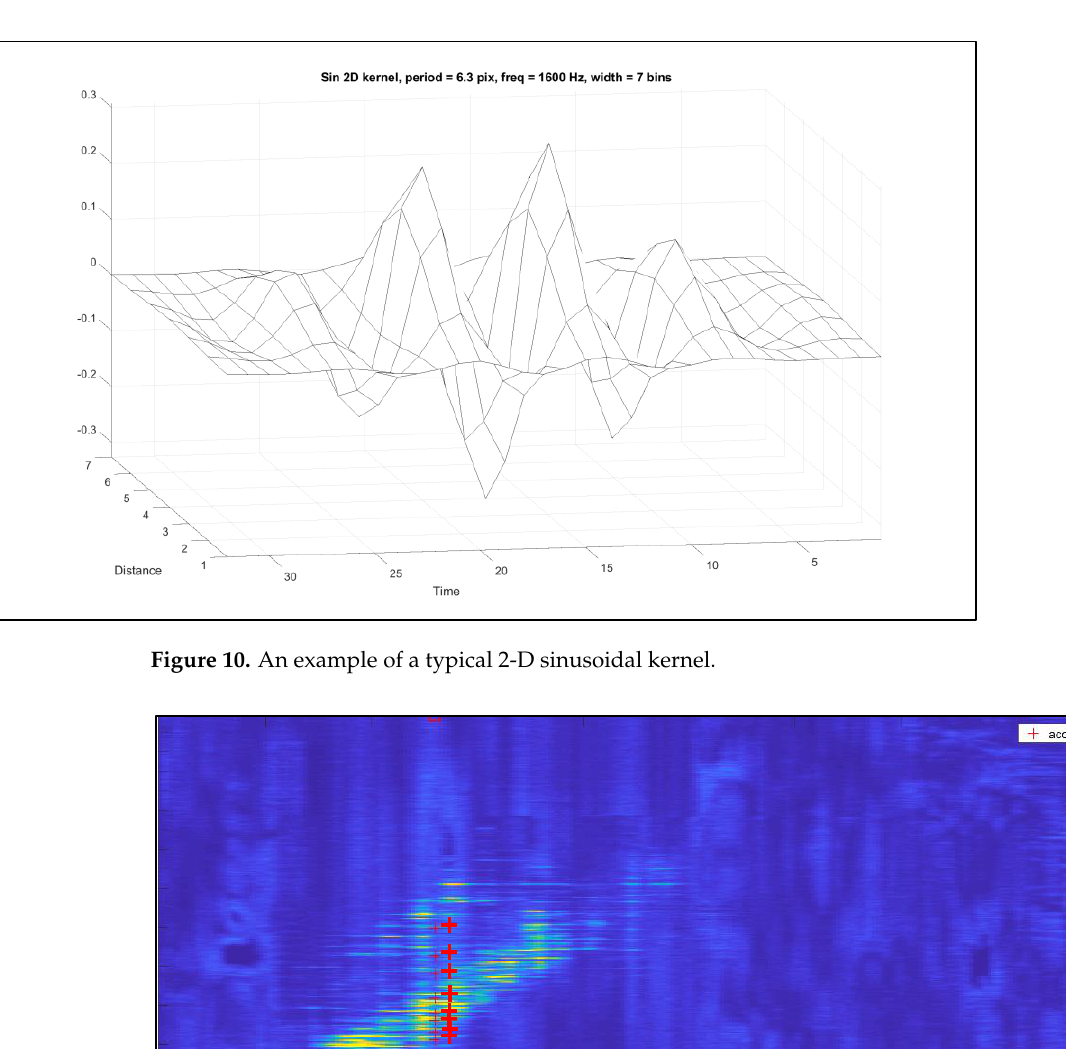
Figure 9. Train consist convolution with a gap of 25 mm and a speed of 25 km/h.